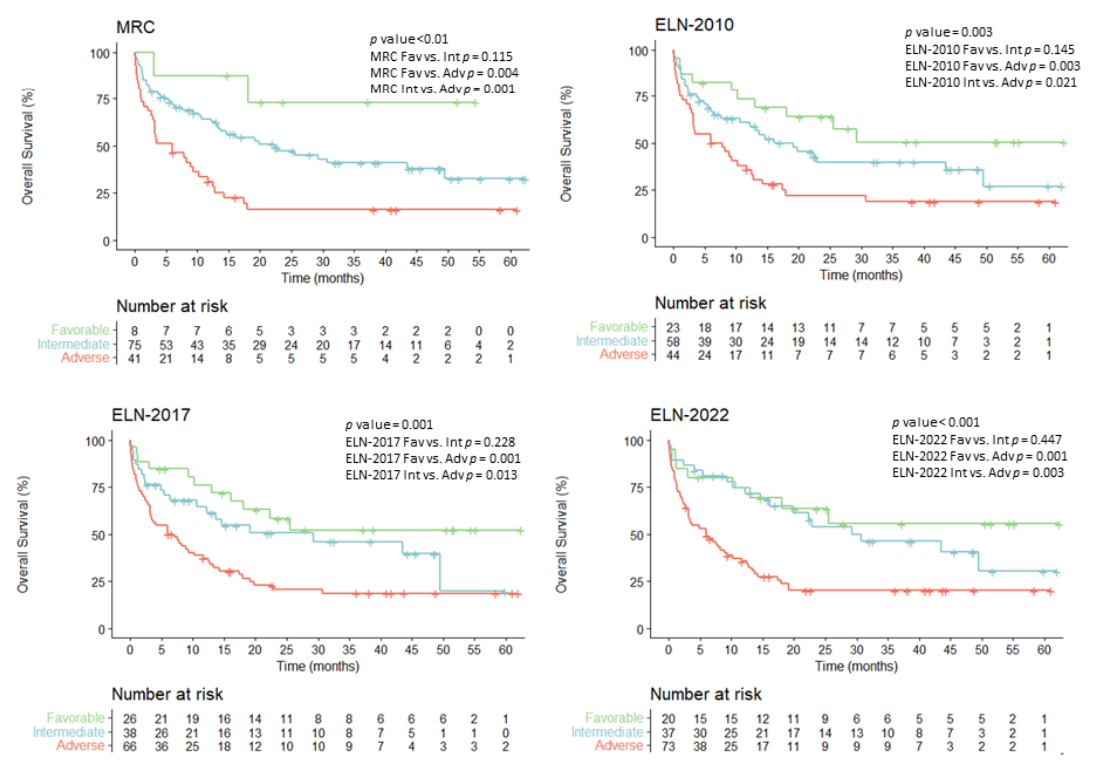
Figure 4. Overall survival probability for the entire cohort ( n = 130) according to the evolving risk